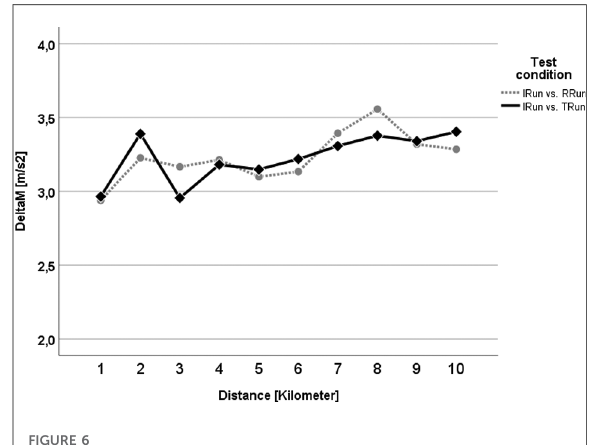
FIGURE 6 d M analysis for the control run vs. the T rhombus) and the R Run (grey dotted line with circle). No statistical difference can be seen.